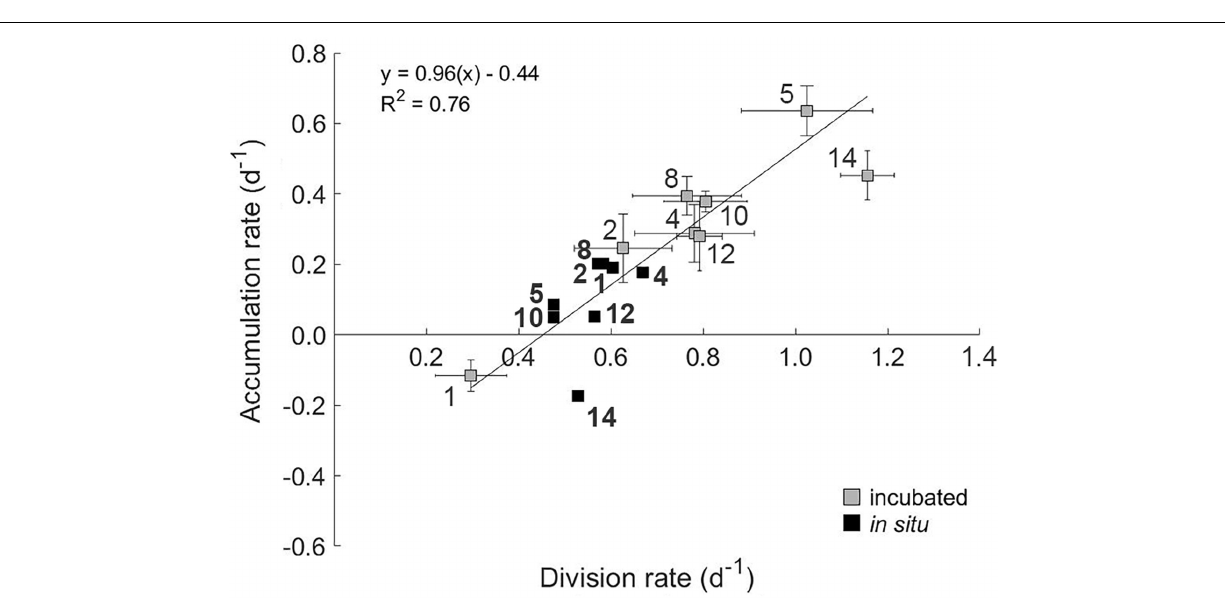
FIGURE 6 | The relationship between accumulation rate and gross division rate of phytoplankton communities subjected to a light disturbance during experimental incubations (gray squares). Station number are indicated on plot. Error bars represent standard error. A geometric mean regression of division rates within the phytoplankton community during dilution incubations and PAR levels < 0.5 mole photons m − 2 h − 1 was used to calculate the growth of the phytoplankton at in situ light levels (black squares). Station numbers associated with in situ division rates are shown in